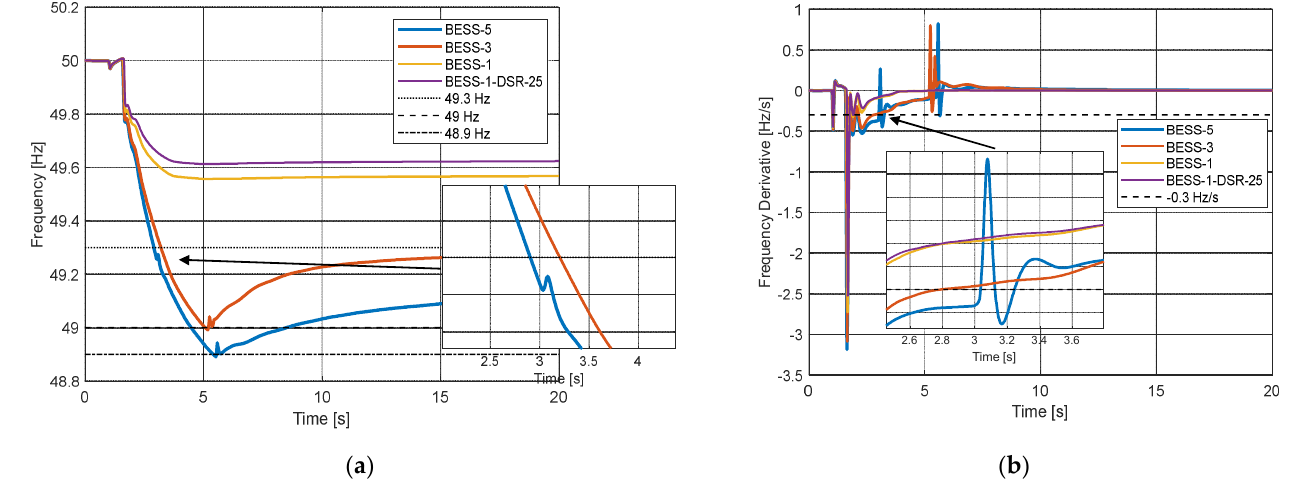
Figure 8. High Import DP, outage of two of the three connections with continental Italy: ( a ) frequency profiles; ( b ) frequency derivative profiles.